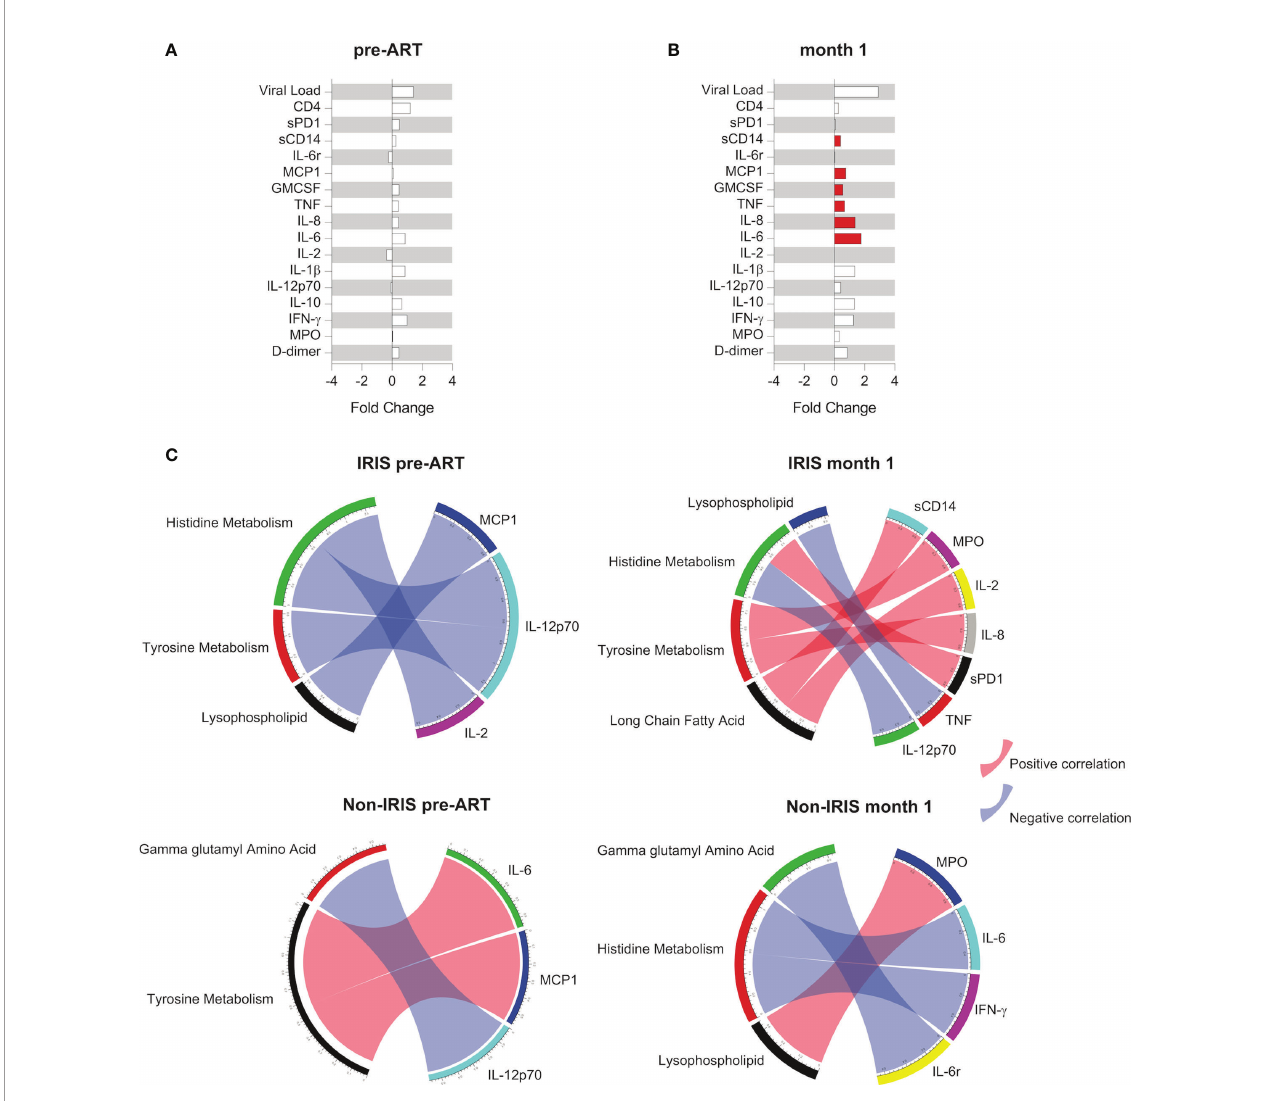
FIGURE 4 | Association between metabolic pathways and systemic in fl ammation in IRIS. Fold change analysis between IRIS and non-IRIS groups of HIV viral load, total CD4 + T cell count, and levels of plasma biomarkers are shown for the pre-ART (A) and month 1 (B) time points. The statistically signi fi cant differences are shown in red bars. (C) Spearman correlations between levels of plasma biomarkers and normalized enrichment score from the co-expressed pathway modules at the pre-ART and month 1 time points for IRIS and non-IRIS groups are depicted. Blue arcs represent negative correlations, and red arcs represent positive correlations. Only statistically signi fi cant correlations with p -value <0.05 and correlation coef fi cient (r) above 0.7 or below -0.7 are